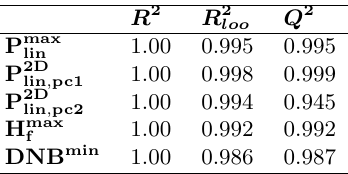
Table B.4. Kriging models validation for IBE coupling.